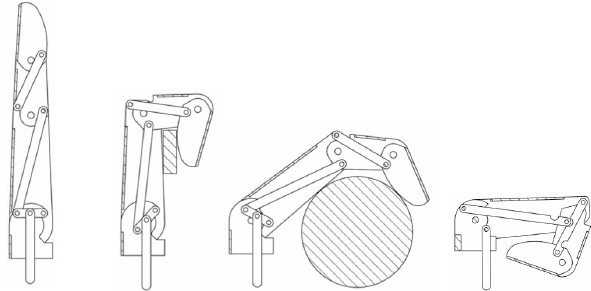
Figure 2. Use of the equalising mechanism across the finger to allow an adaptive grip. if the proximal phalanx is stopped by an external object. the distal phalanx closes onto the object. for a larger object the finger curls similar to the design in Fig. 1.if unobstructed, the tip wraps round to the base of the